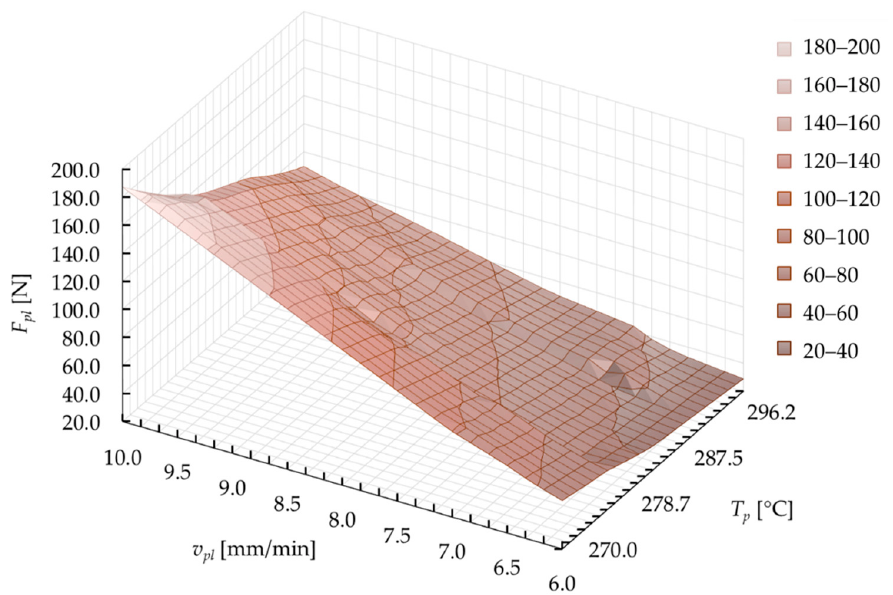
Figure 25. Exemplary results in the form of the plasticization force surface F pl in correlation with the hot plate temperature T p and the plasticization velocity v pl for the belt with diameter of 18 mm.